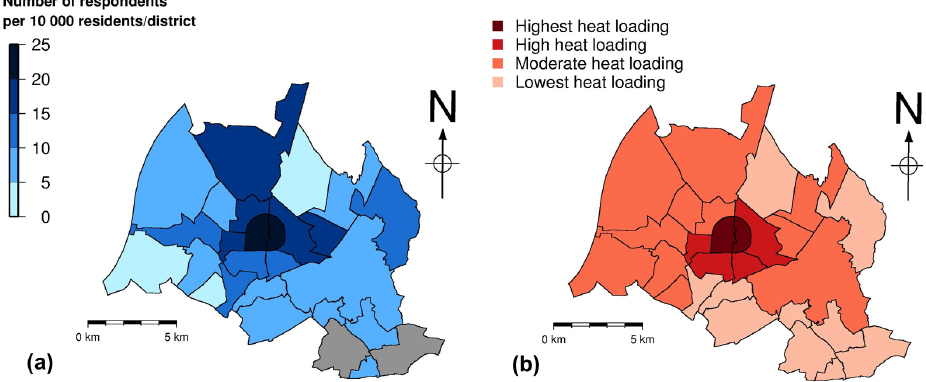
Figure 2. (a) Number of respondents in districts of Karlsruhe per 10000 inhabitants/district. (b) Category of heat loading assigned to the 27 districts of Karlsruhe. The gray color in the figure (a) indicates that there was no participation from this district in the study.